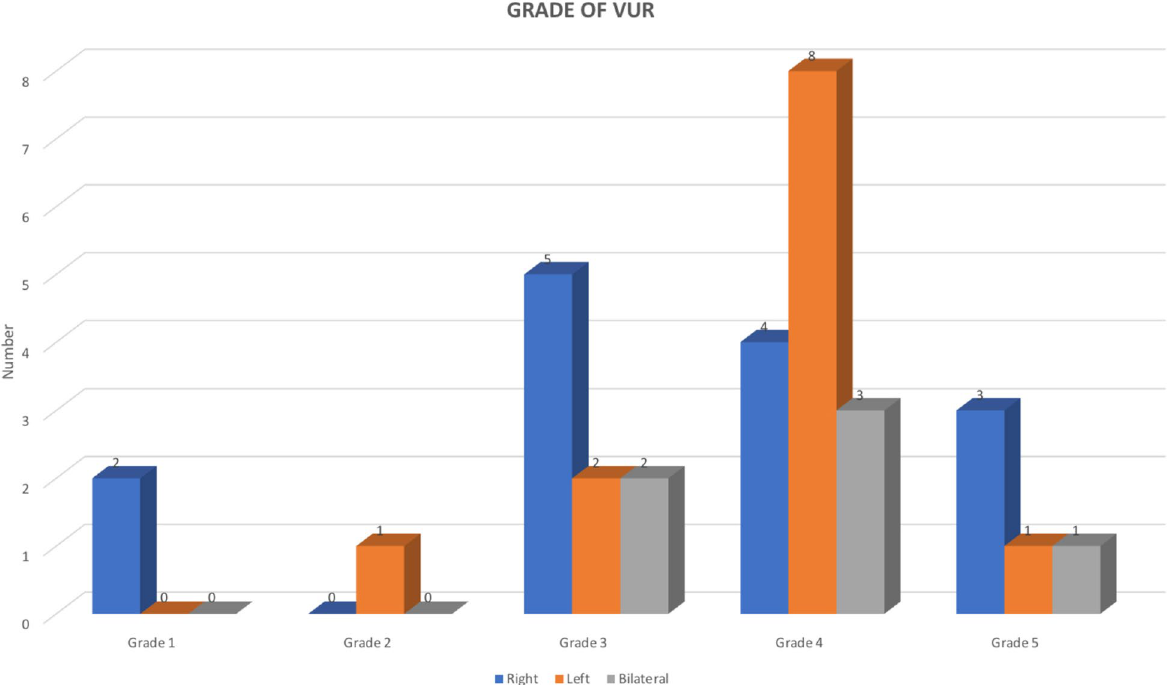
Fig. 3 Graph depicting the frequency distribution of different grades of VUR in our